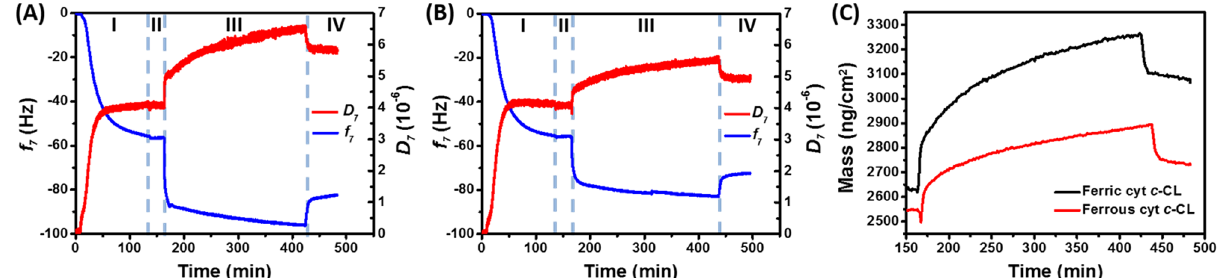
Figure 2. Frequency (blue) and dissipation (red) shifts (7th overtone) of a SiO 2 QCM-D sensor. The sensor was sequentially exposed to the CL/DPPC liposomal solution (Section I), Tris–HCl buffer (Section II), cyt c solution (Section III), and Tris–HCl buffer (Section IV). ( A ) and ( B ) correspond to ferric and ferrous cyt c , respectively. ( C ) The masses of the adsorbed ferric (black) and ferrous (red) cyt c were estimated based on the Kelvin–Voigt model. Concentration of CL/DPPC liposome: 230 μM; concentration of cyt c : 50 μM.